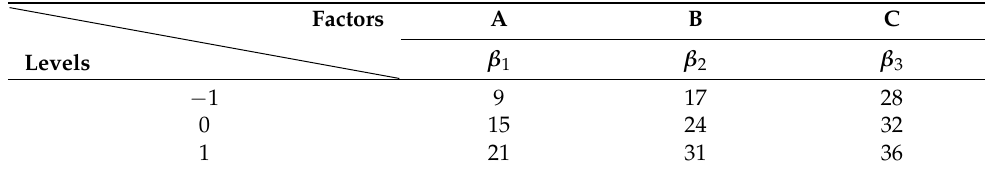
Table 5. Table of experimental